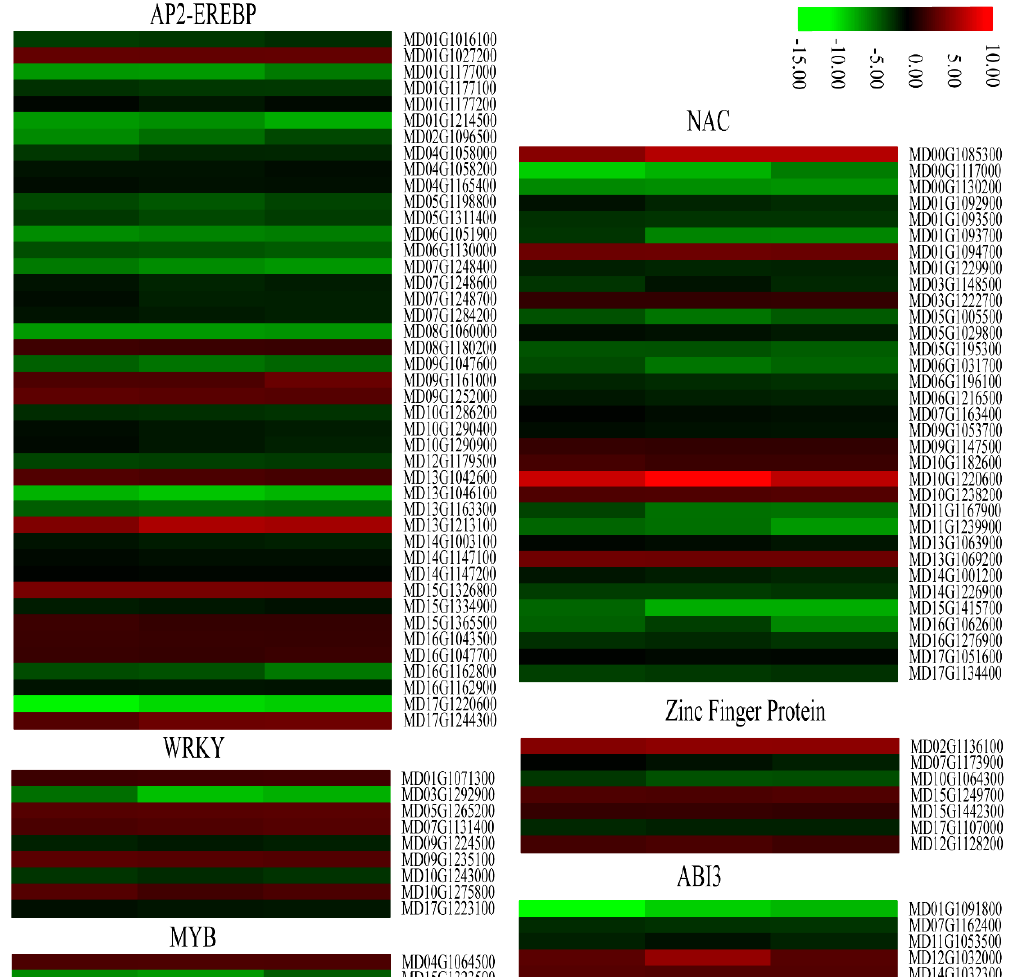
Figure 9. Heatmaps of DEGs encoding transcriptional factors. The log2|Foldchange| was colored using TBtools (red indicates the DEG was up ‐ regulated in the MdMLP423 ‐ overexpressing calli compared with the CK calli, green indicates it was down ‐ regulated). Each row represents three independent comparisons (T_1/CK_1, T_2/CK_2, and T_3/CK_3) from left to right.